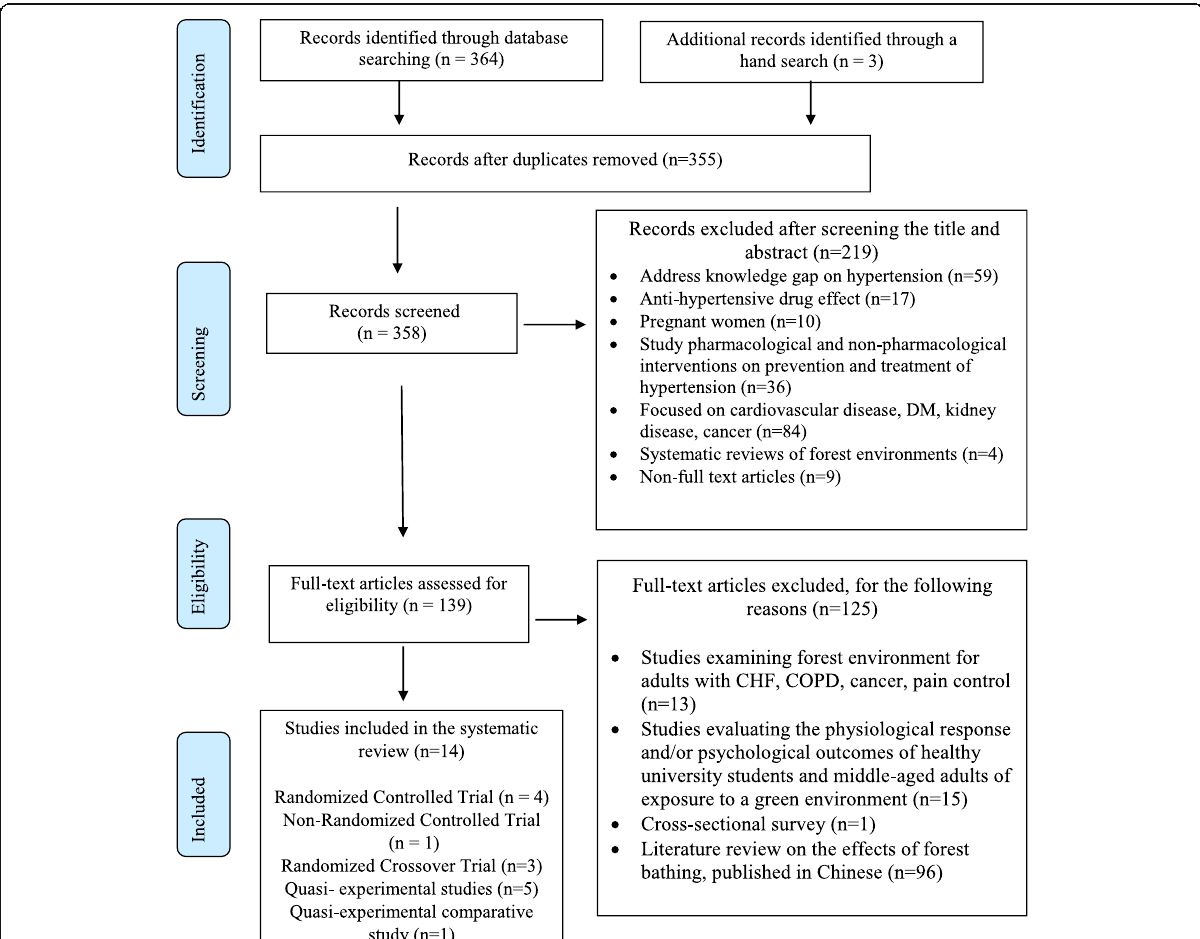
Fig. 1 Flow chart of the literature search process (PRISMA